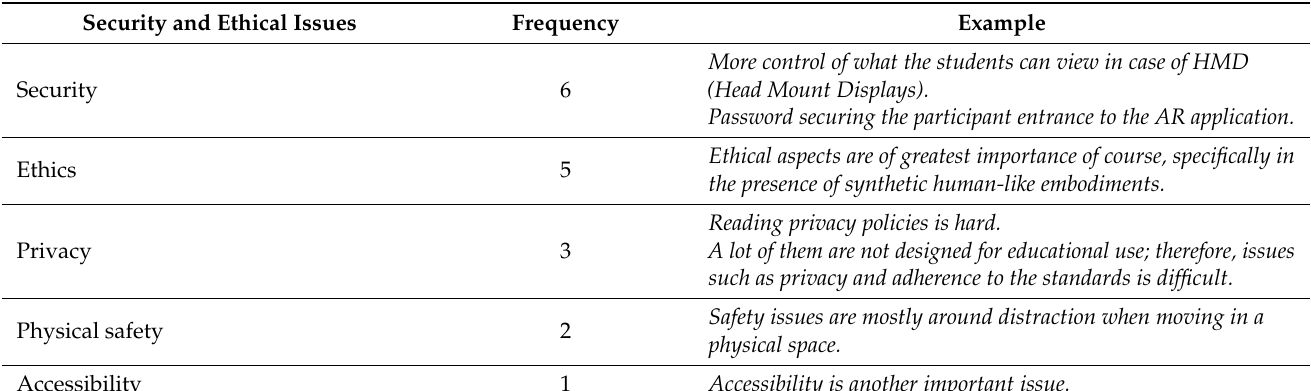
Table 9. Security and ethical issues in integrating